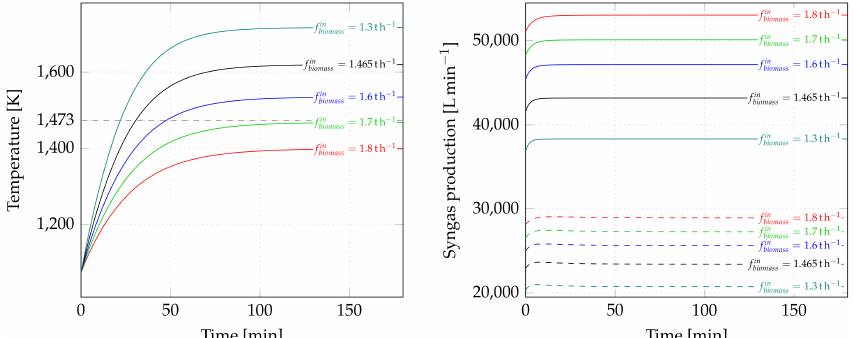
Figure 5. Evolution of the reactor’s temperature for various biomass flow rates when DNI is equal to 900Wm − 2 and corresponding syngas production (dashed line: H 2 ; solid line: H 2 + CO).